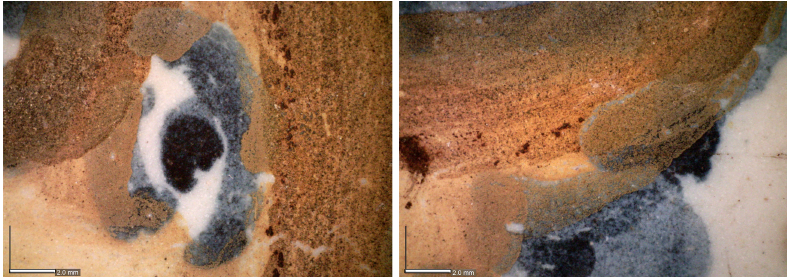
Figure 7. Micrographs from the yellow, blue and orange colours. Scale bar is 2 mm